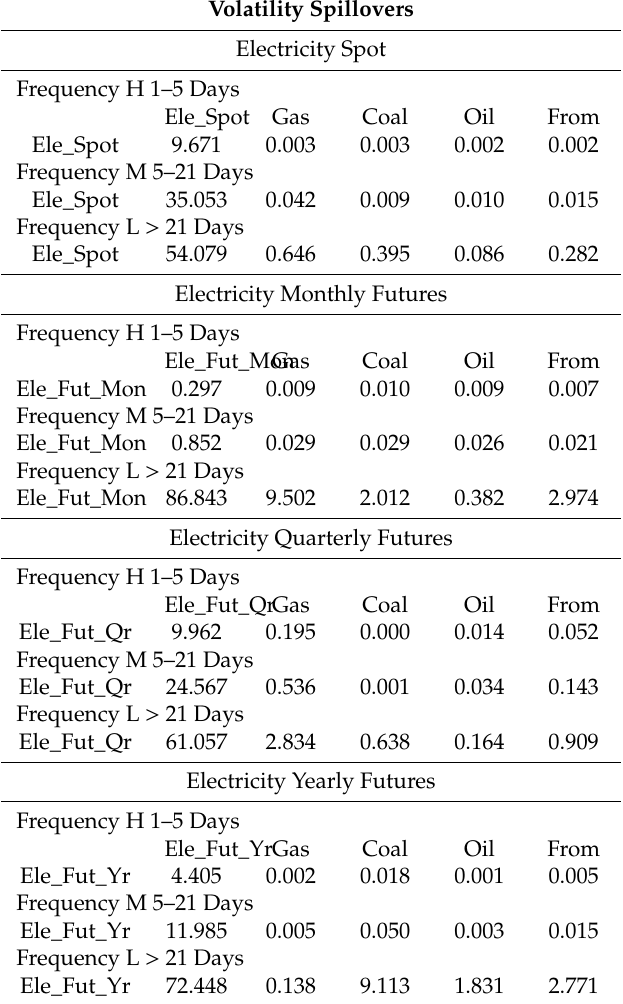
Table 8. The volatility spillover results of the Barunik–Krehlik methodology